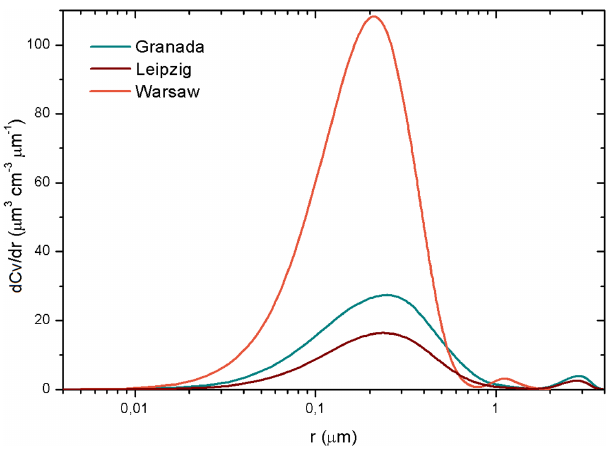
Figure 9. Volume particle size distributions retrieved for the se- lected points of the analyzed smoke plumes. Table 5. Concentration values integrated along each smoke layer. Superscripts f and c indicate fine and coarse mode separation, re-